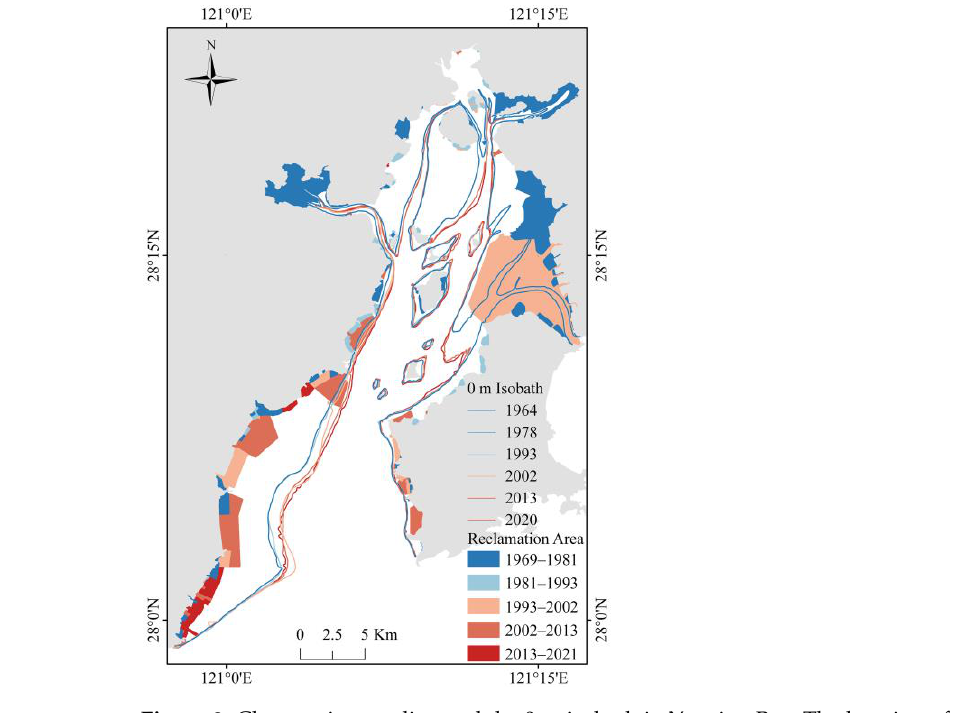
Figure 3. Changes in coastline and the 0 m isobath in Yueqing Bay. The location of the coastline was determined by the outer boundary of the reclamation area in each time point.